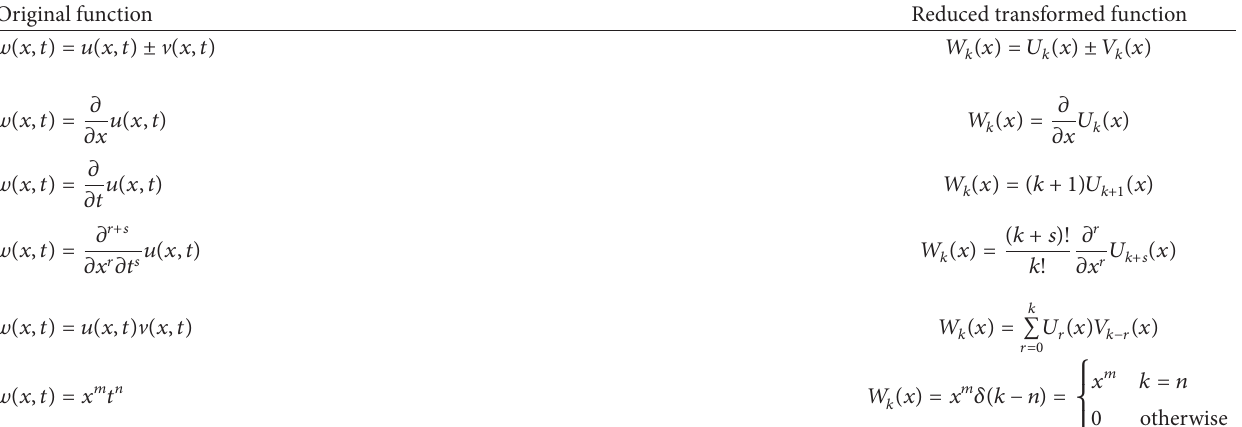
Table 2: The fundamental operations of two-dimensional